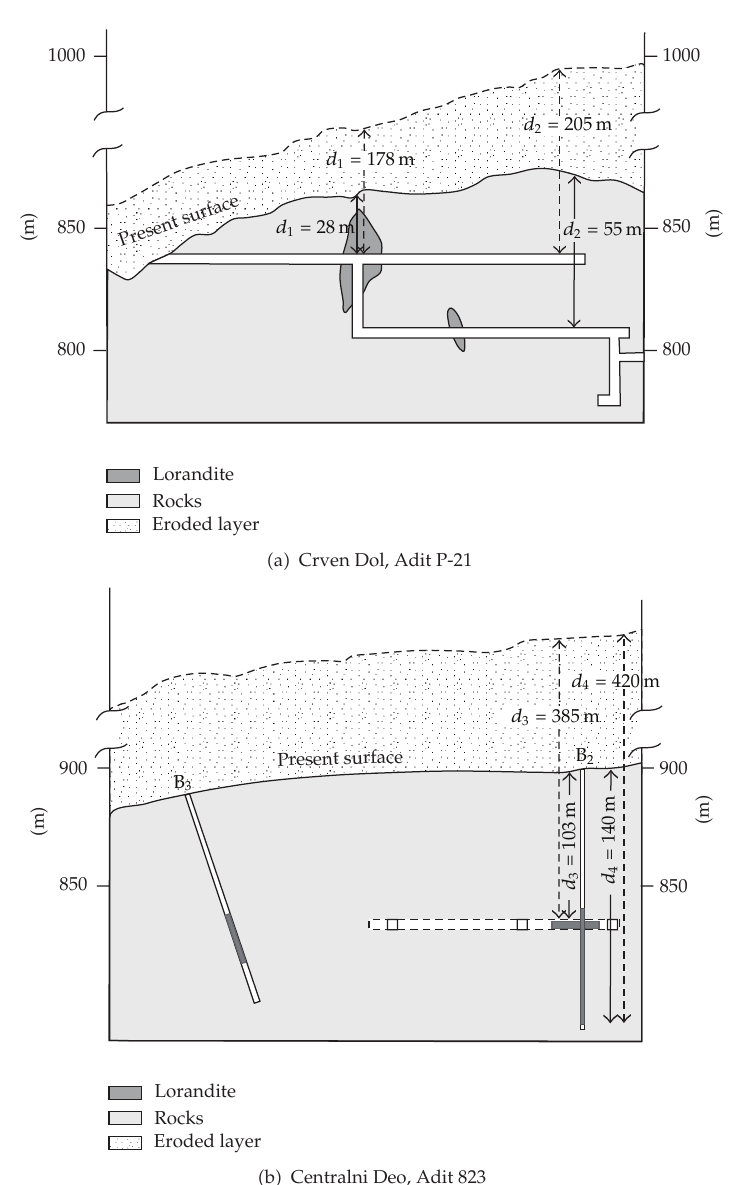
Figure 1: Geological cross-section of the ore body Crven Dol (cid:2) a (cid:3) and Centralni Deo (cid:2) b (cid:3) of the Allchar ore deposit together with the presumably eroded